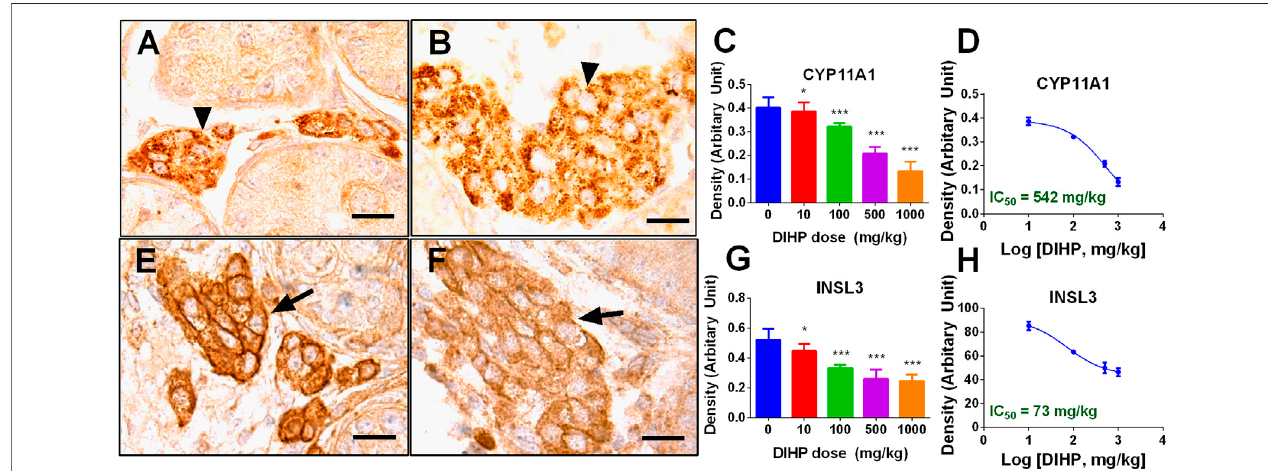
FIGURE5| Semi-quantitativeimmunohistochemical analysis ofCYP11A1and INSL3protein levels after exposuretoDIHP inpregnancy. Figure (A – D) : CYP11A1; Panel (E – H) : DIHP. Representative images (A – B) : CYP11A1 stained at 0 and 1,000 mg/kg DIHP; (E – F) : INSL3 stained at 0 and 1,000 mg/kg DIHP; Panels (D, H) : IC 50 values. Mean ± SEM, n (cid:1) 6; * p > 0.05, *** p < 0.01 indicate that the signi fi cant level between the DIHP group and the control group, respectively.